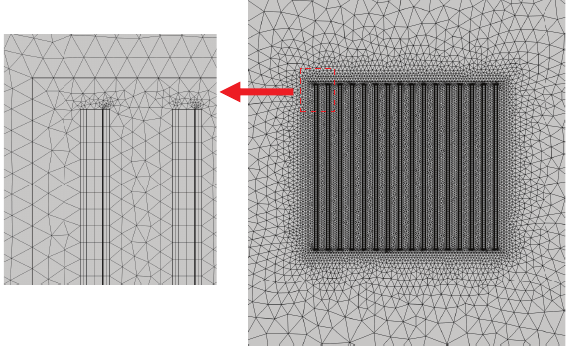
Figure 2. Mesh profile of the YBCO